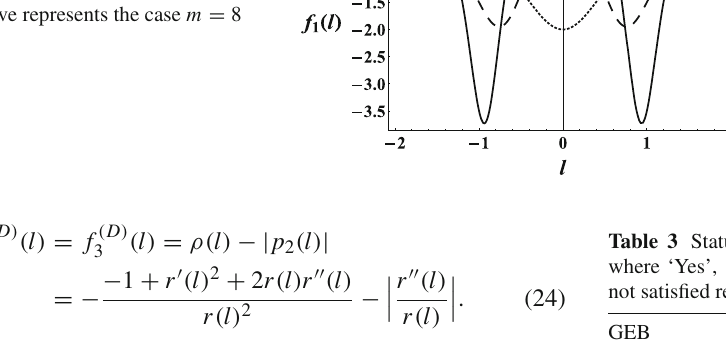
Fig. 2 Plot of inequality functions of DEC (for b 0 = 1), where dotted curve represents case m = 2, dashed curve represents case m = 4 and thick curve represents the case m = 8